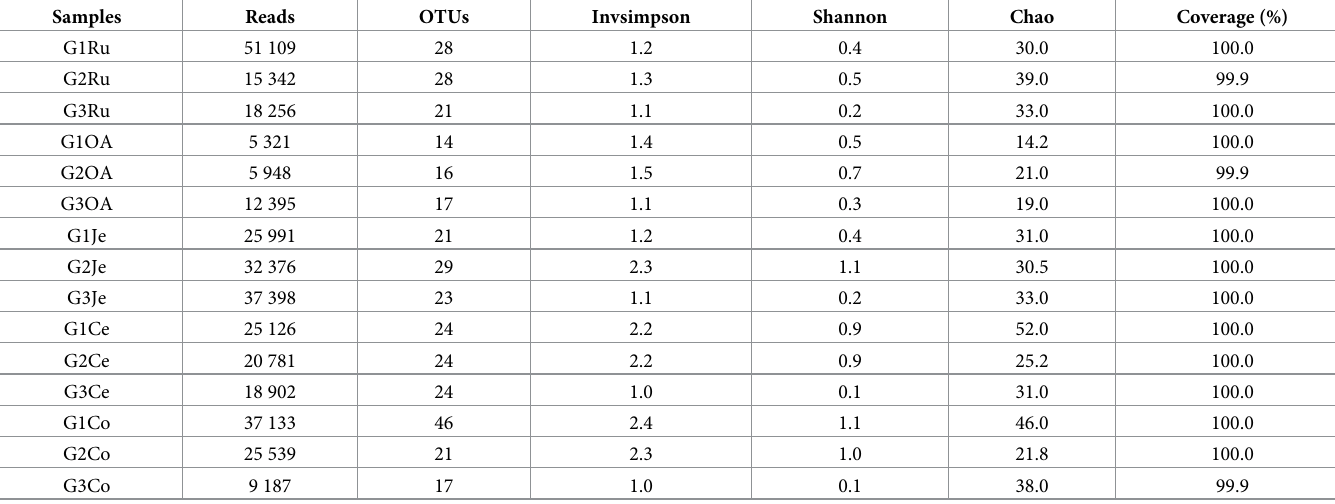
Table 2. 16S rRNA gene sequences, richness and alpha-diversity estimates of Archaea at the GIT of three goats. Samples